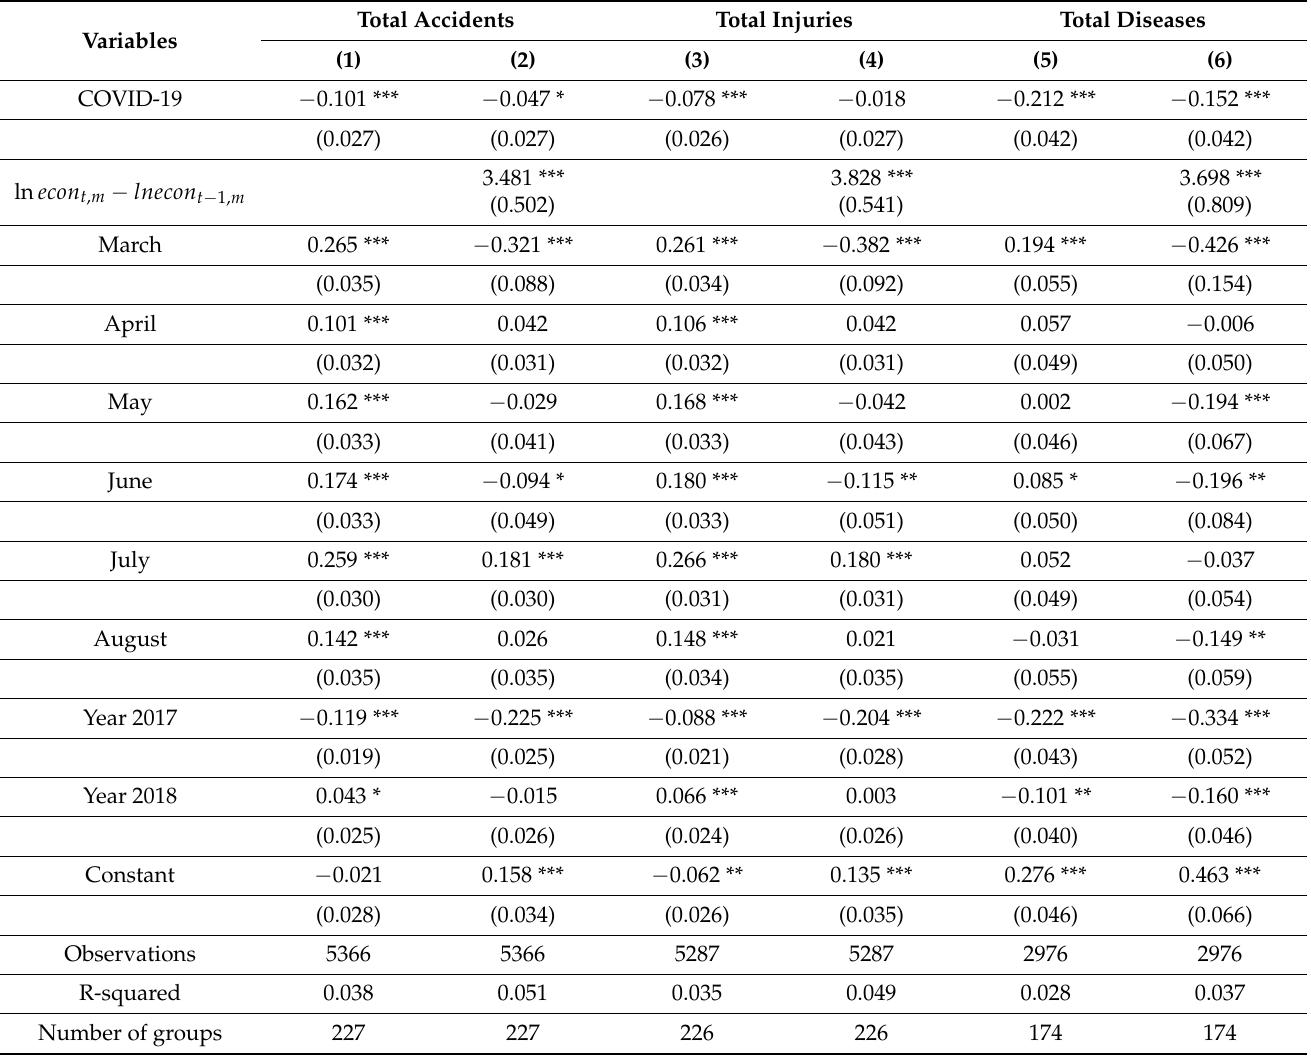
Table 2. Estimation results of fixed effects